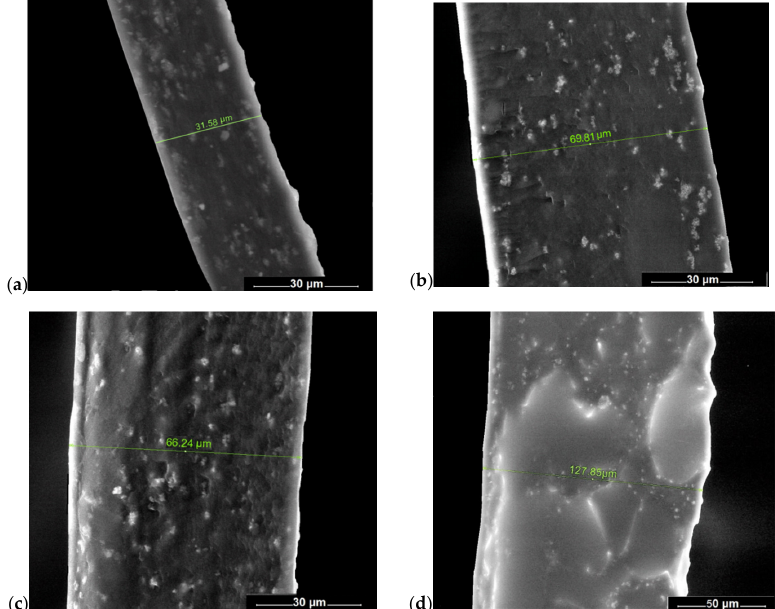
Figure 2. Representative cross-section SEM images of ( a ) CS-TS, ( b ) CS-TS-HS, ( c ) CS-TS-TPP, and ( d ) CS-TS-PDMS composite membranes.